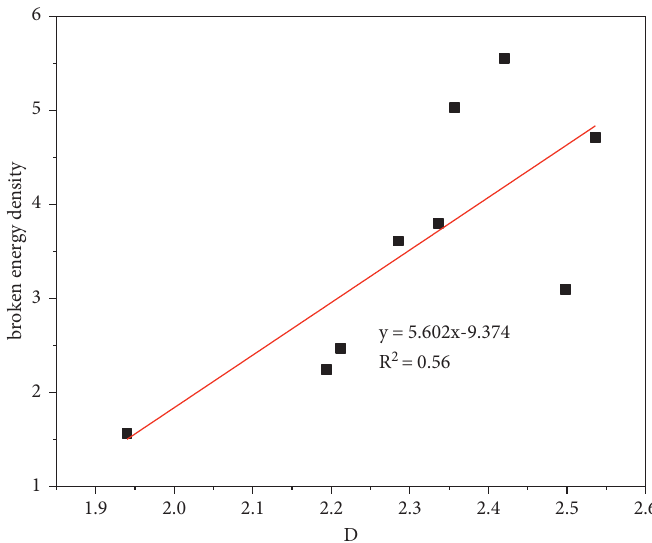
Figure 9: Correlation between specimen fractal dimension and specimen broken energy